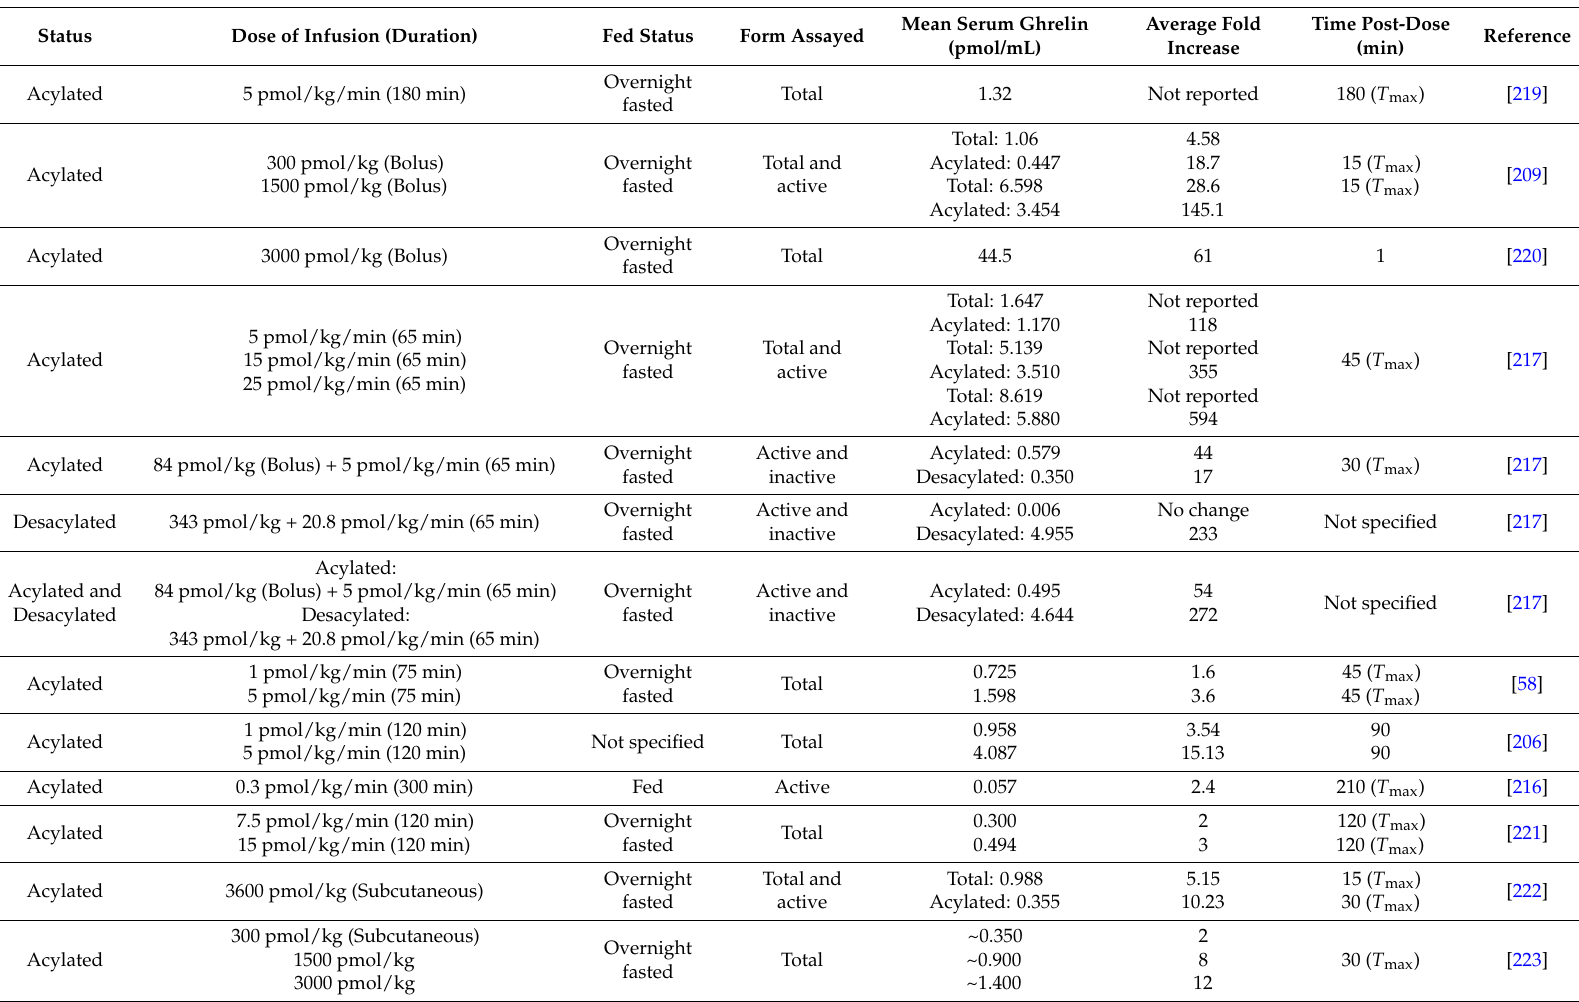
Table 1. Pharmacokinetic data available from clinical studies involving